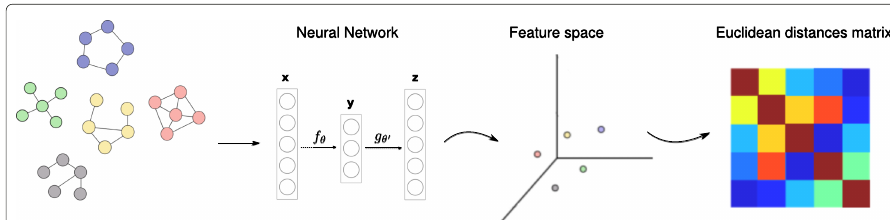
Fig. 1 Overview of the proposed method. Given a family of graphs, we train an unsupervised neural network in order to uncover dissimilar relationships between graphs. The graphs are embedded into a feature space and mapped to a Euclidean distance matrix reflecting the structural similarity between input